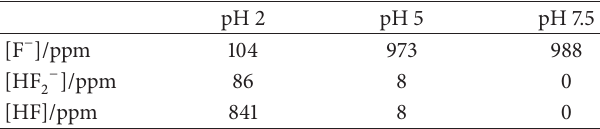
Table 3: Calculated concentrations of F − , HF 2− , and HF for pH 2, 5, and 7.5 and 1000ppm total fluoride